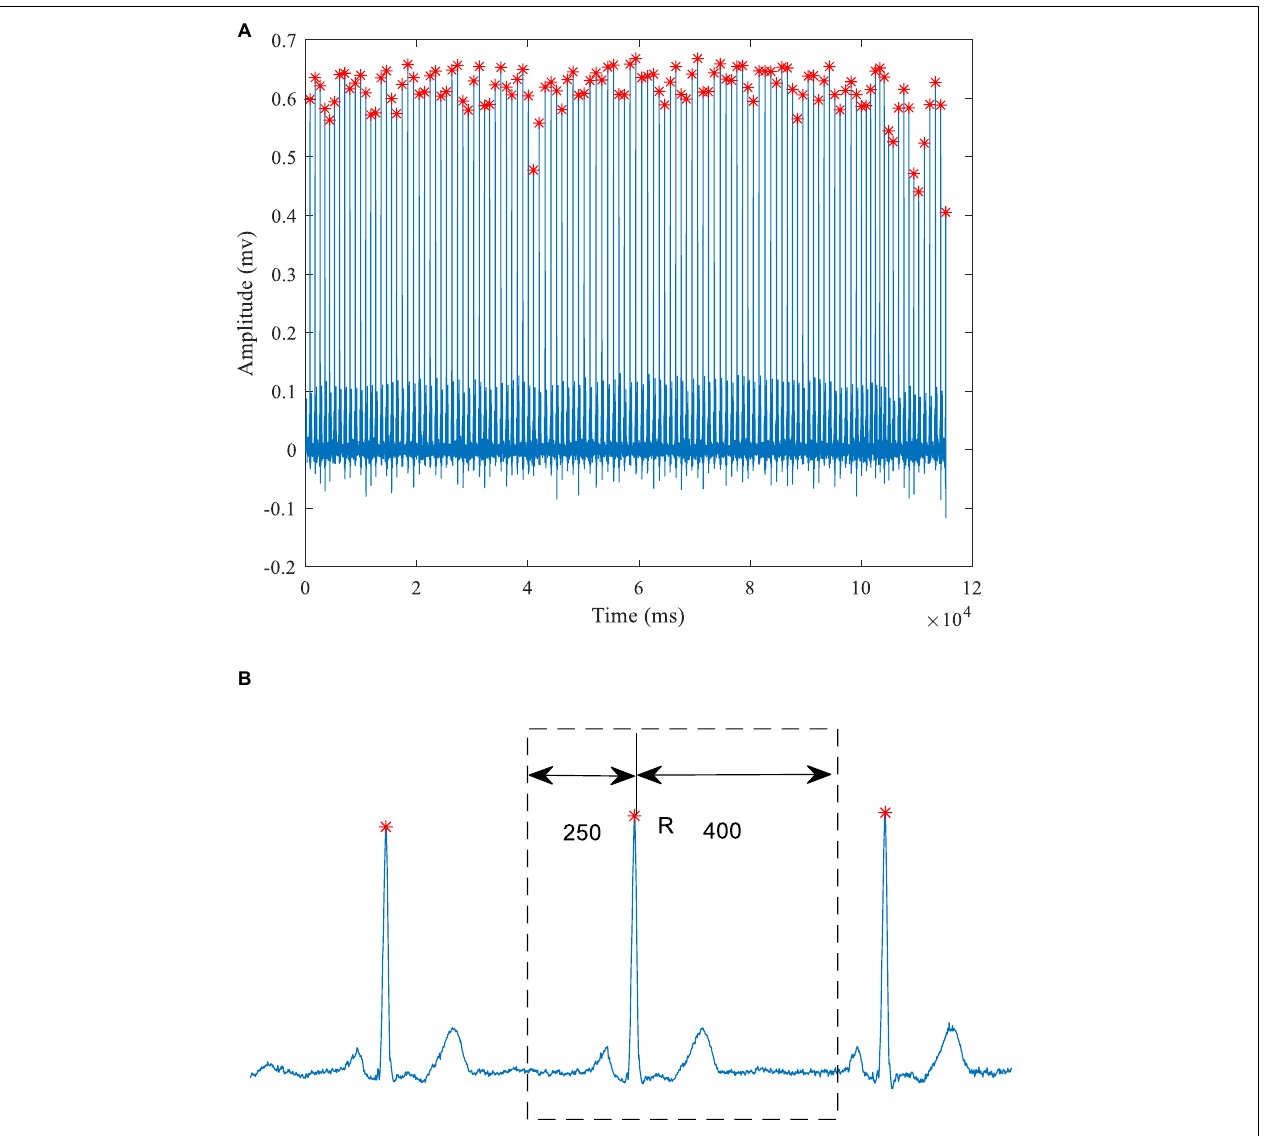
FIGURE 2 | A typical ECG signal (A) Identification of the R-wave peaks (red crosses) (B) schematic diagram of heartbeat extraction.